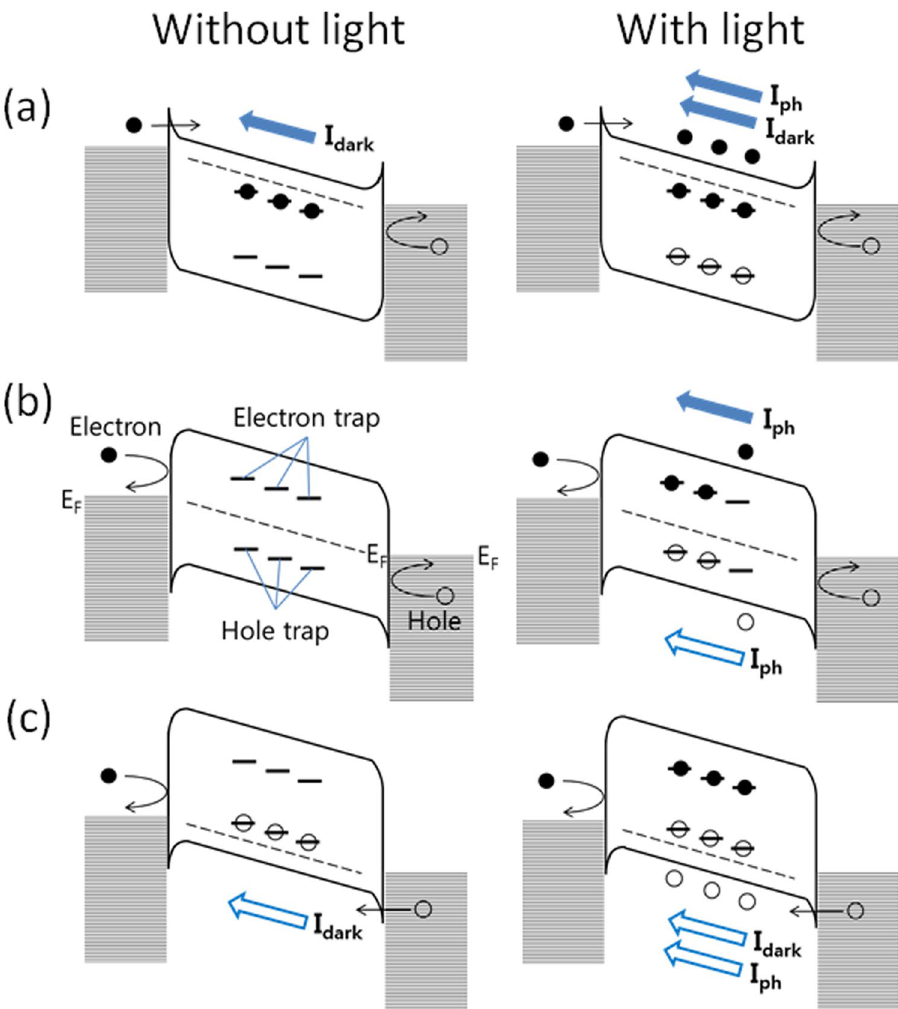
Figure 3. Schematic energy band diagrams of MoSe 2 phototransistors with and without light ( a ) at V g = 40 V, ( b ) at V g = 0 V, and ( c ) at V g = − 40 V under an applied bias ( V d